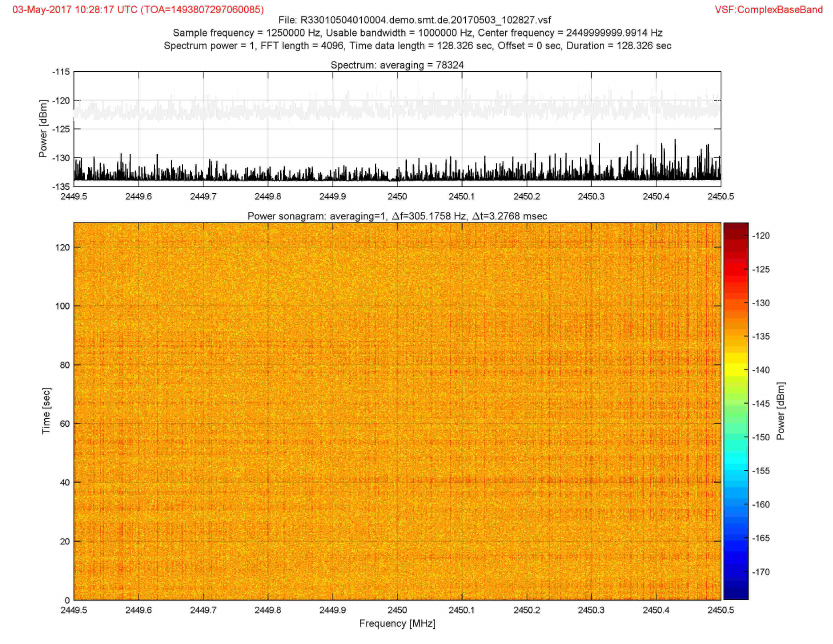
Figure 16. Complex base band signal measured from